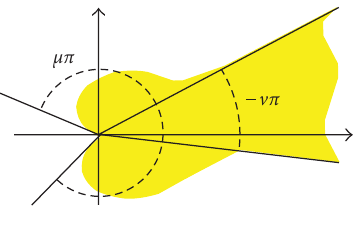
Figure 2.1. Angle